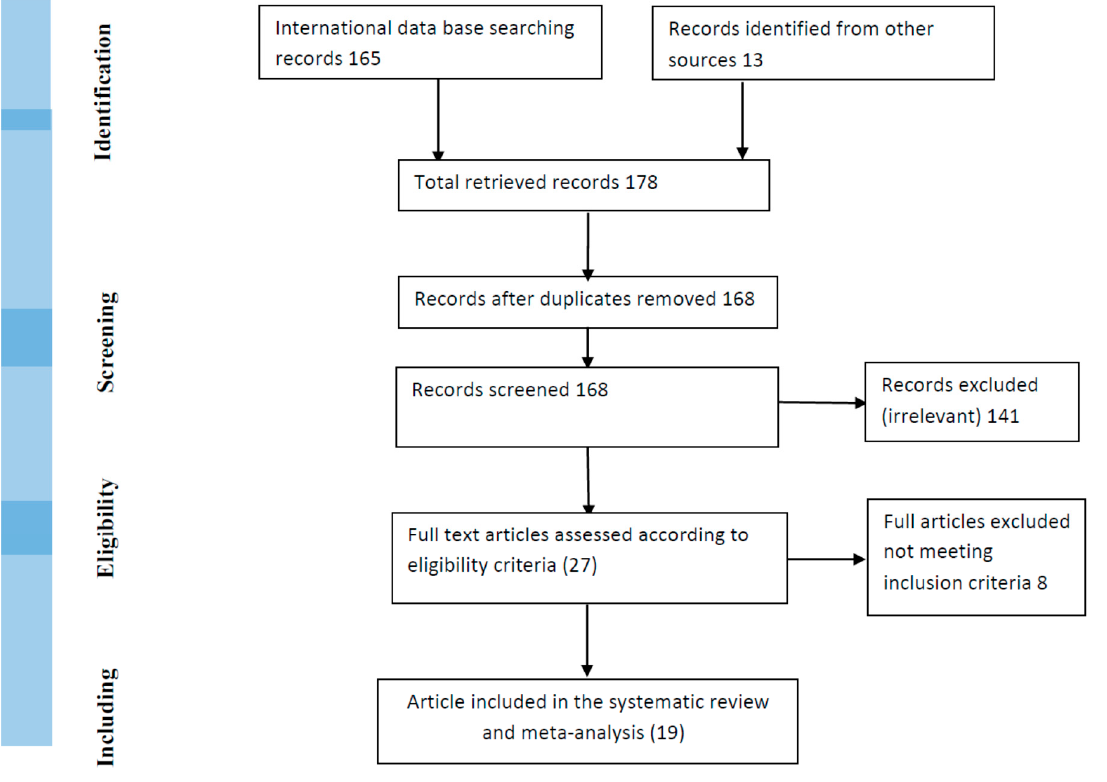
Figure 1. Study inclusion flow chart.